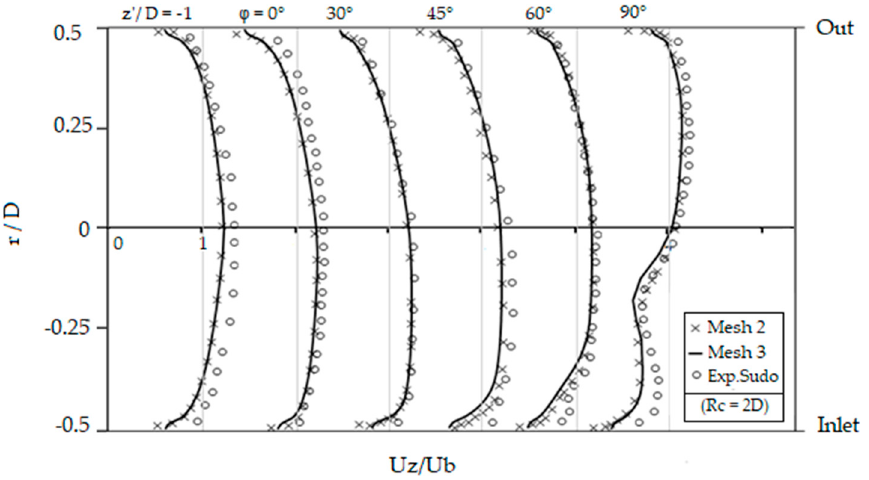
Figure 6. Longitudinal flow velocity profile in z’/D = − 1, φ = 0°, 30°, 45°, 60° and 90°. RNG k- ε model. Experimental data of Sudo et al. (Re = 60,000) [10].